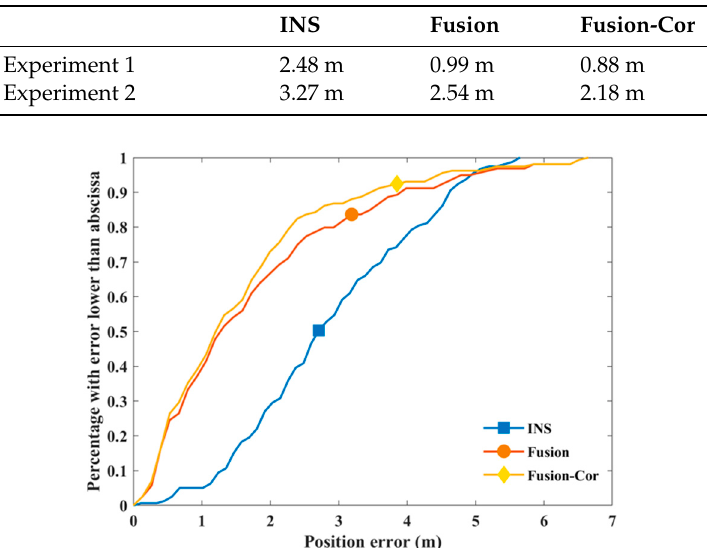
Figure 7. Cumulative distribution function (CDF) of position error. Table 3. Mean position error.